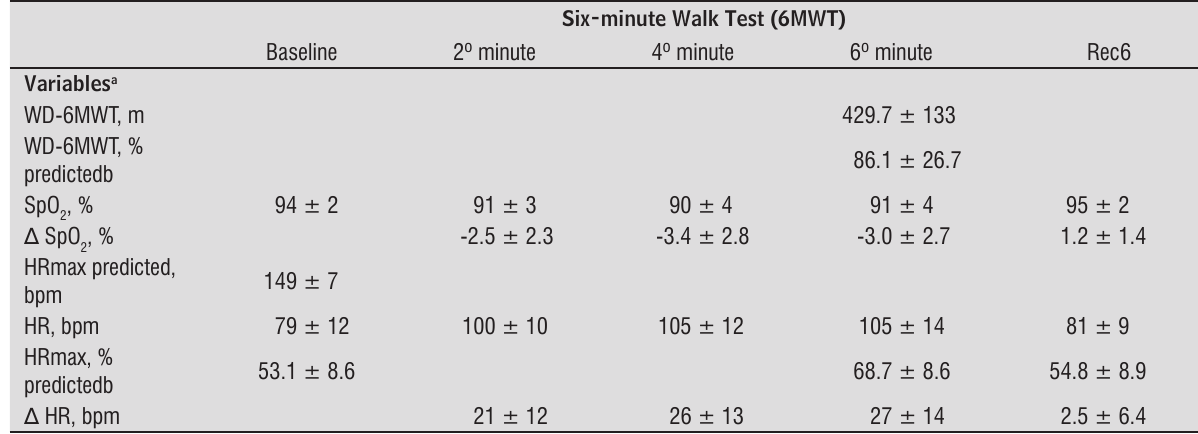
Table 2 - Walked distance and physiological variables in the 6MWT